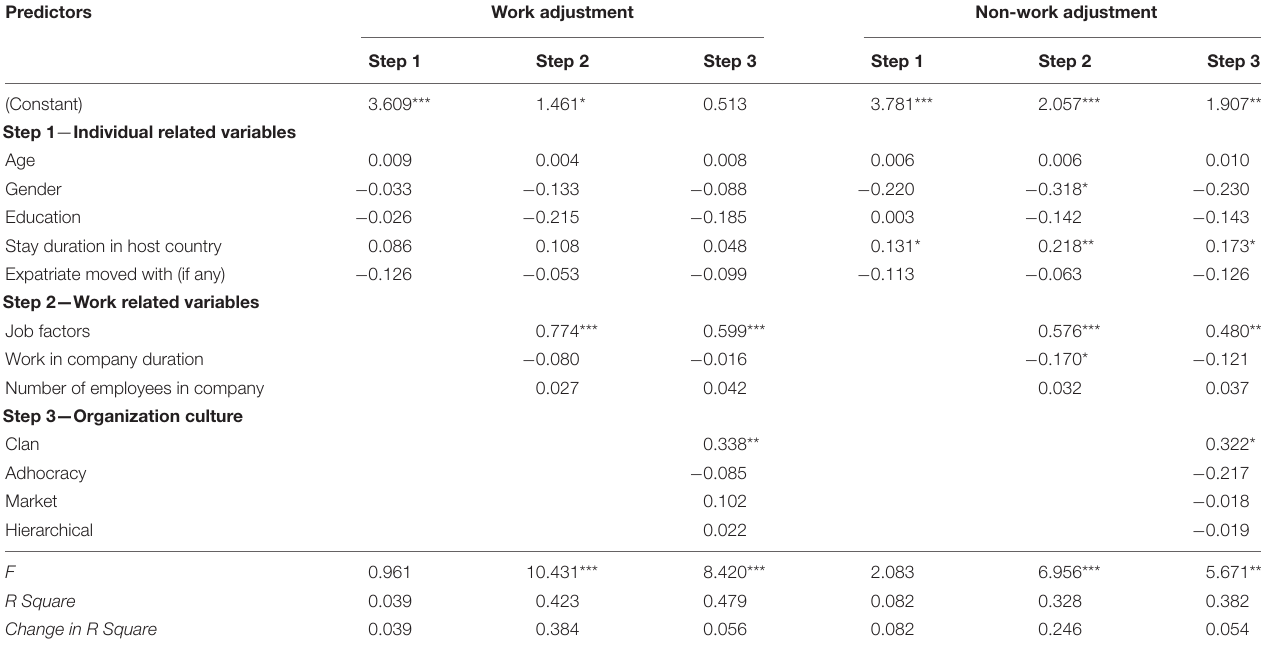
TABLE 3 | Multiple linear regression predicting the degree of expatriates’ adjustment